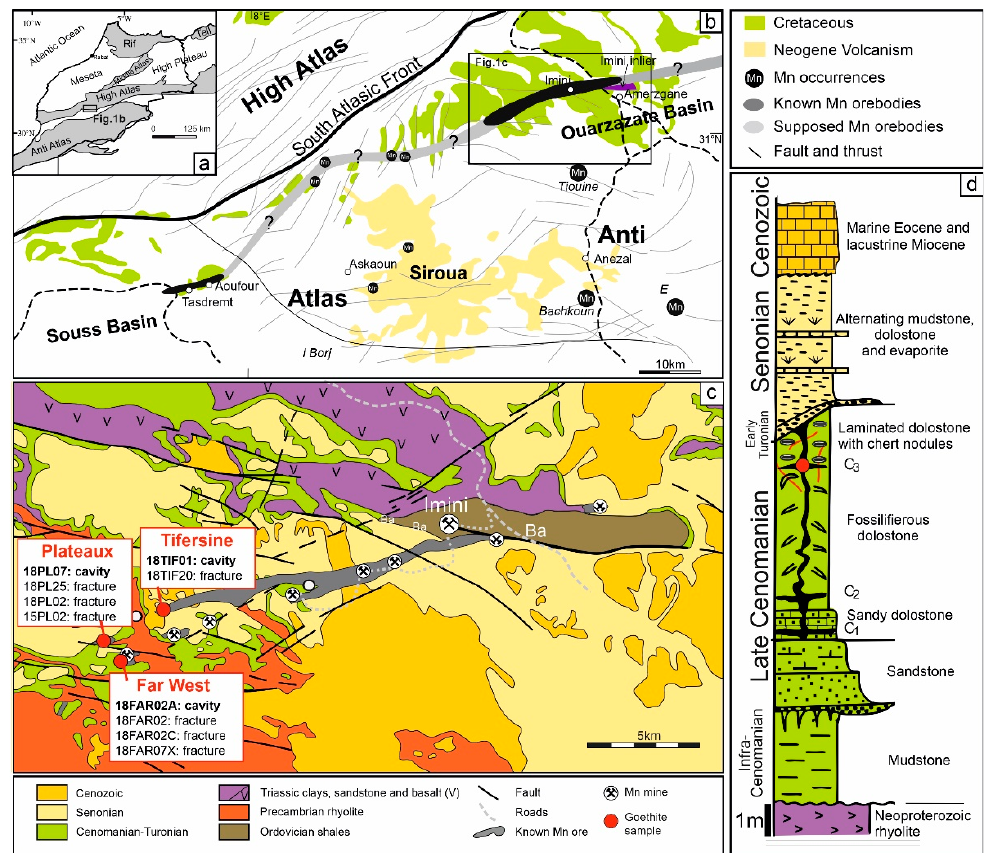
Figure 1. ( a ) Simplified structural map of Morocco. ( b ) Geological map of the Cretaceous sediments, Neogene volcanism and Mn occurrences [14]. ( c ) Geological map of the Imini district showing the location of Far West, Tifersine and Plateaux deposits [12]. ( d ) Stratigraphic log of the western part of the district [13]. Cross-section is presented in [11].